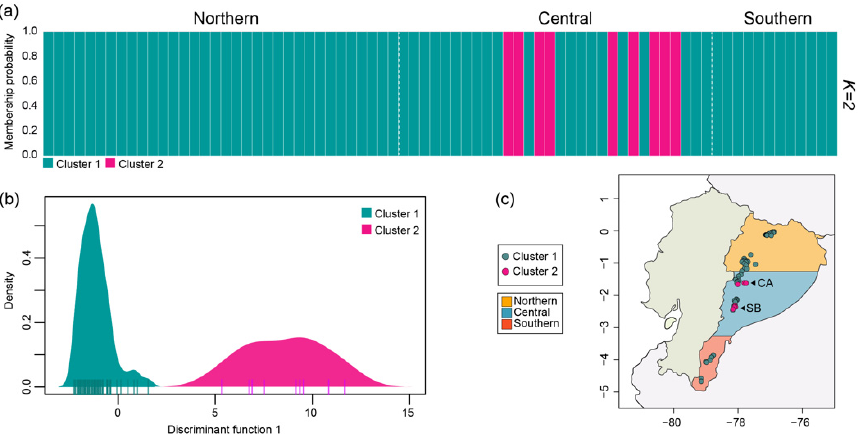
Figure 2. DAPC for 76 Ilex guayusa individuals selected after clone correction. Each genetic cluster is represented with a different color. ( a ) Component plot of the individuals ordered by their latitude for the inferred ancestry at a K = 2 as calculated by the DAPC: Cluster 1 (teal), Cluster 2 (pink); ( b ) density plot of the first discriminant function of the DAPC analysis; ( c ) geographic locations of the individuals belonging to the Cluster 1 and Cluster 2. The annotation CA and SB indicate the collection sites of Canelos and Sevilla don Bosco, respectively.